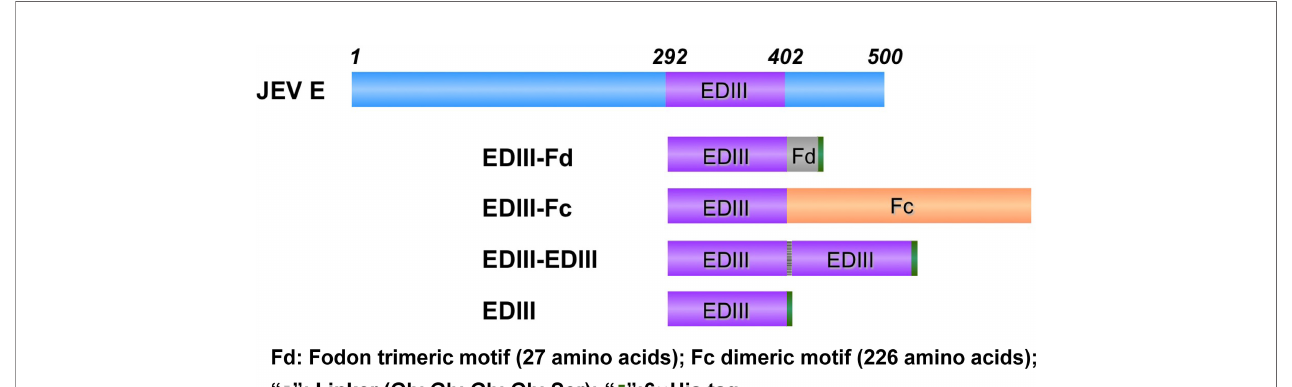
FIGURE 1 | Design of recombinant JEV EDIII fragments. Schematic diagrams of JEV E protein and recombinant EDIII fragments are shown. EDIII contains a C- terminal His6 tag; EDIII-EDIII was constructed by linking two EDIII molecules head to tail through a short linear spacer, and it also contains a C-terminal His6 tag, EDIII-Fc was constructed through a C-terminal Fc dimerization tag; EDIII-Fd was constructed through a C-terminal foldon trimerization tag, and it also contains a C- terminal His6